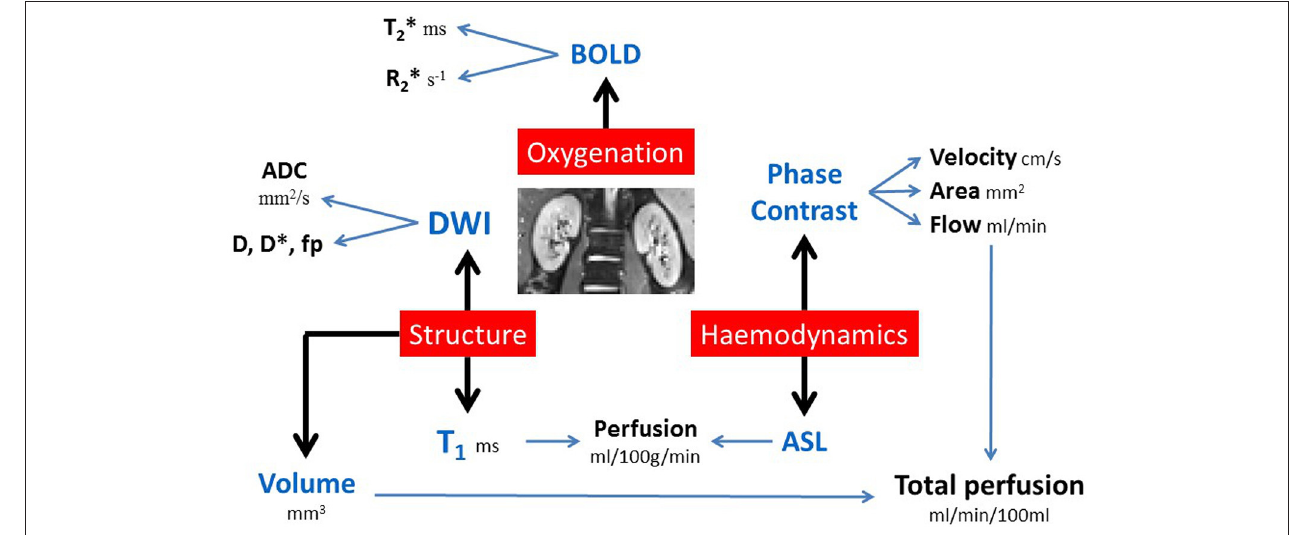
FIGURE 1 | Multiparametric non-invasive renal MRI